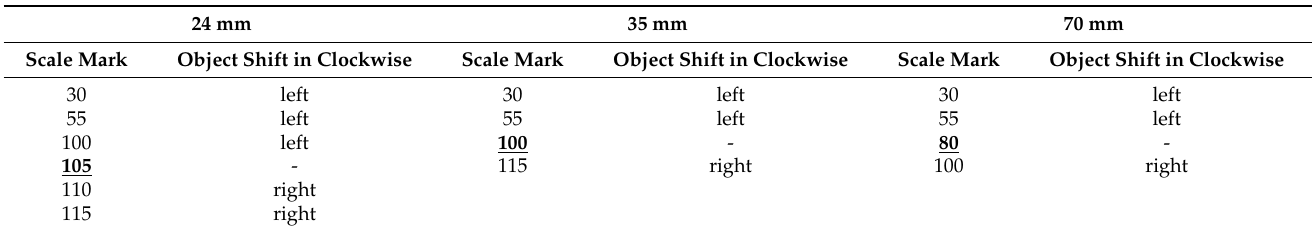
Table 1. Look-up table for eccentric issue with different focal lengths (bold indicates the suggested scale marks).